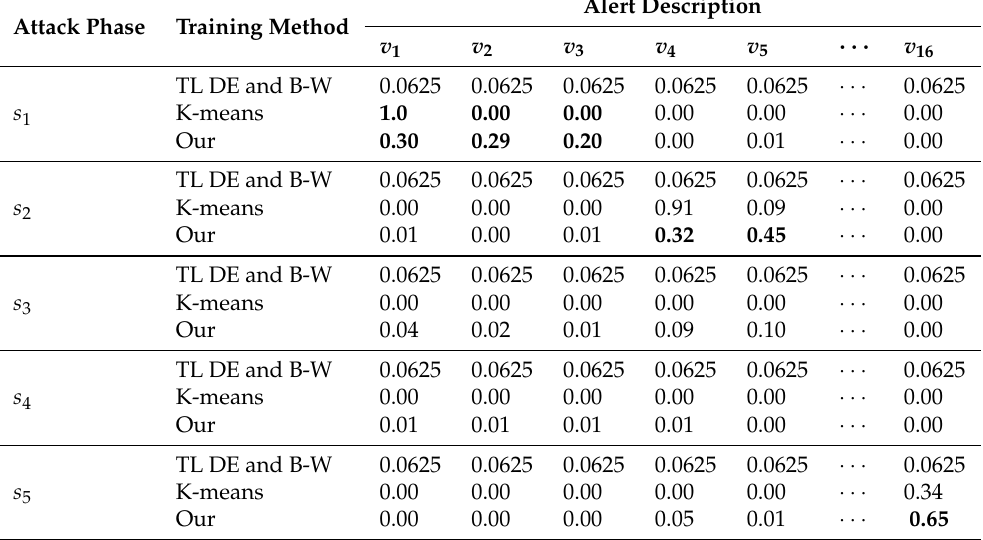
Table 2. The initial parameters of the alert description transition probability matrix B in the DARPA 2000 dataset. s i denotes the i attack phase, v j denotes the j alert description, and the element b i ( j ) in the matrix denotes the probability of the i attack phase generate an alert description j